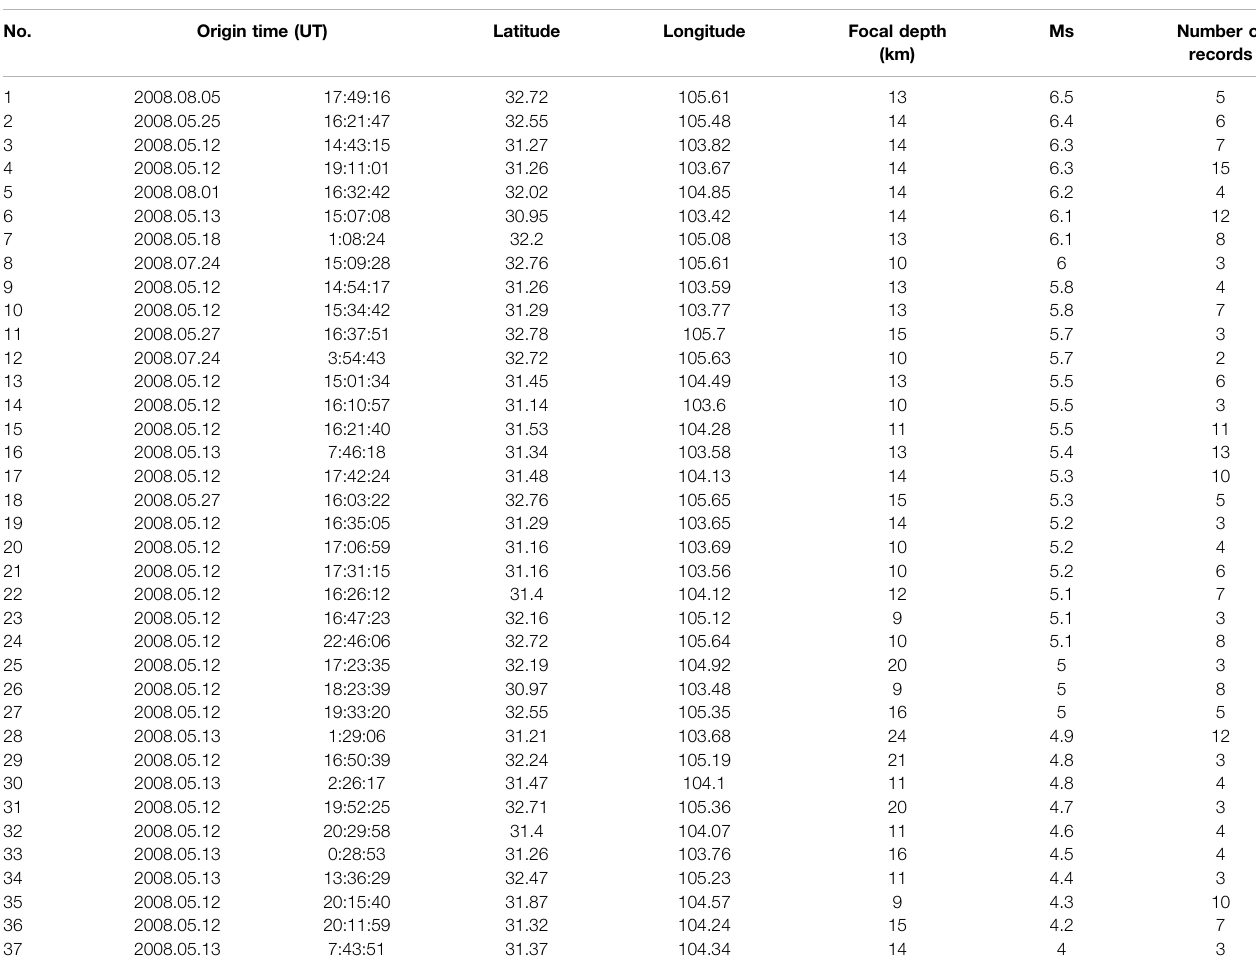
TABLE 1 | Seismic events studied in this